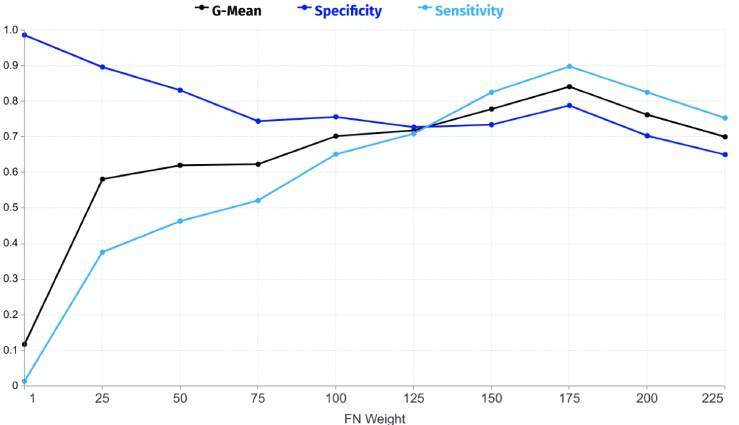
Figure 10. The effects of FN prediction weight on g-mean, specificity, and sensitivity when using the cost-sensitive MHOANN with the PSO for the dataset of Polish companies.